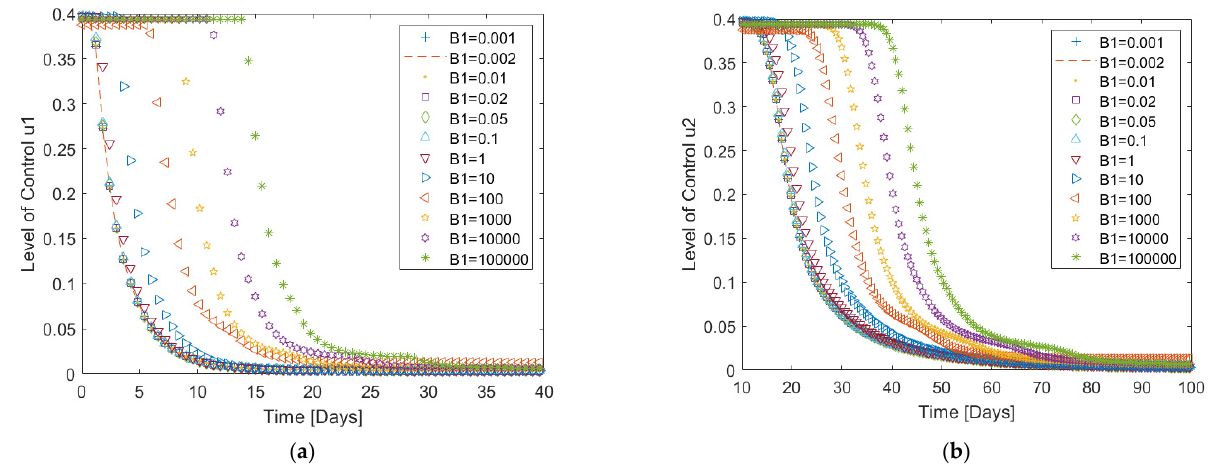
u ; ( b ) Figure 11. The control efforts u 1